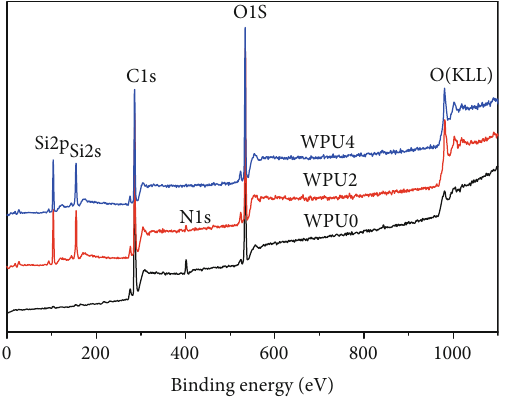
Figure 7: XPS spectrum of LEPS-modi fi ed WPU fi lms.